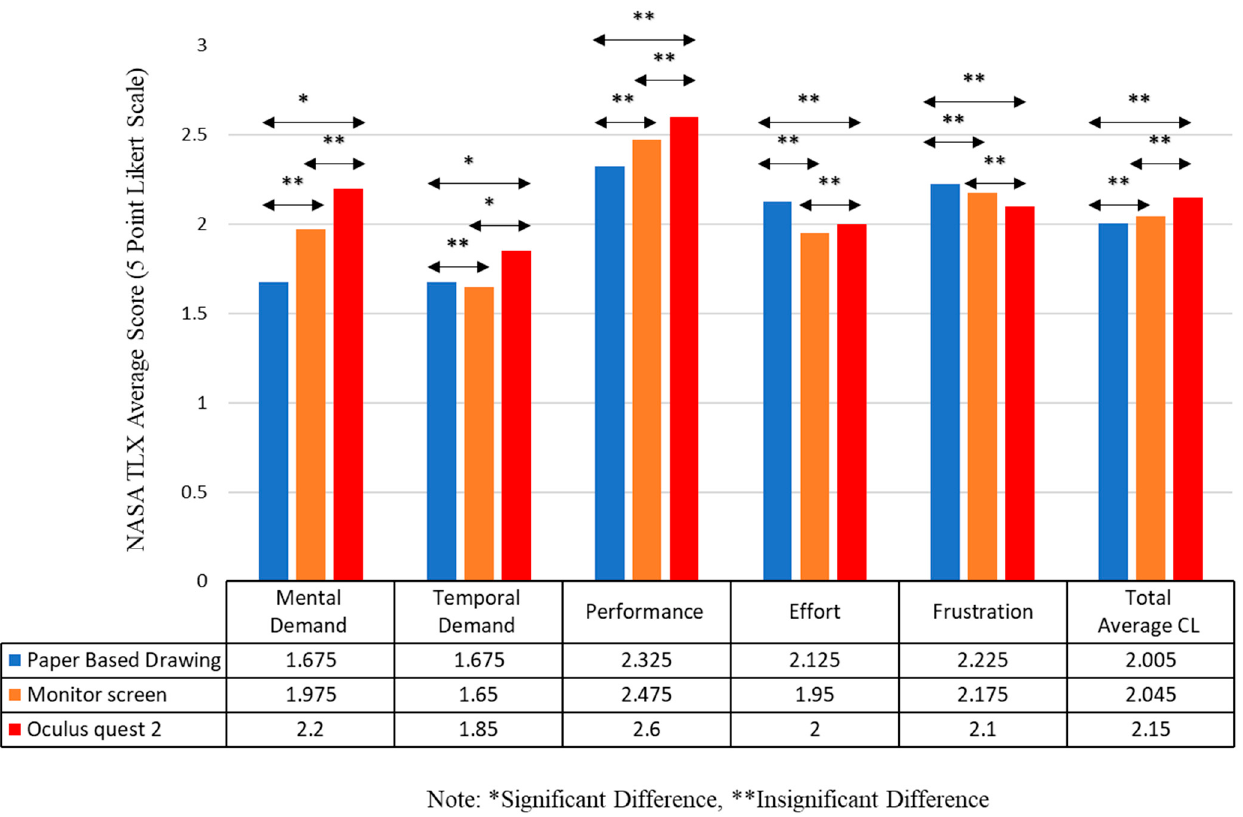
Figure 7. Cognitive load score of participants in the different groups.